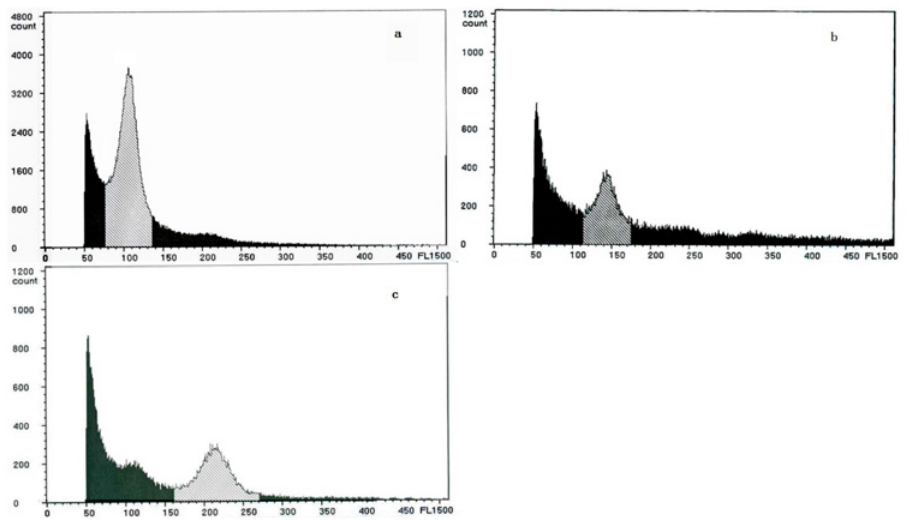
Fig 1. DNA content of sn2.1 (a: the main peak at channel 100), sn3.8 (b: the main peak at channel 150) and sn4.1 (c: the main peak at channel 200). The ordinate (count) represents the relative value of the cell population, the abscissa (FL1) represents the passageway value of fluorescence. The abscissa location which peak point corresponding were the ploidy of test sample.